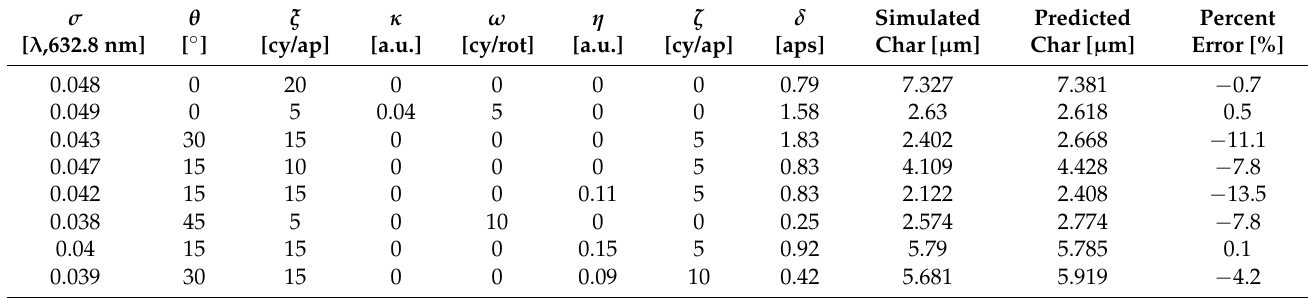
Table 12. Diffraction Ensquared Energy (DENSQ) Characteristic Fit Error, Random Sub-Selection of